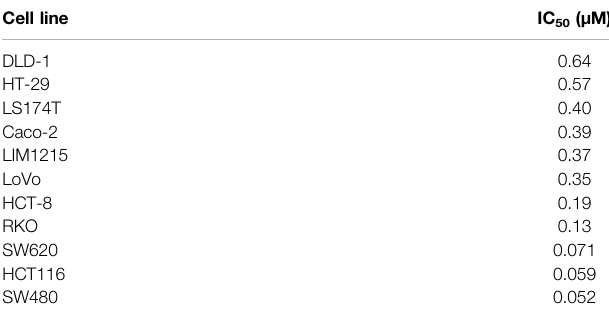
TABLE 1 | Effects on viability of chaetocin on various CRC cells. Cell line